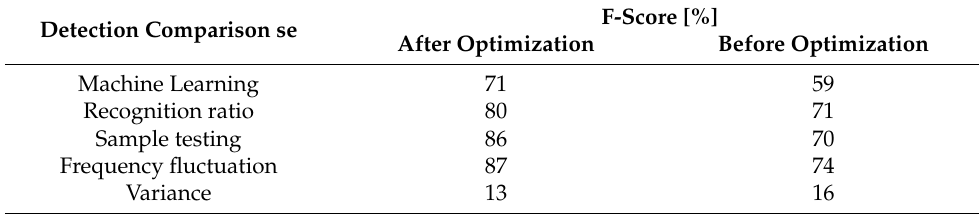
Table 10. Final algorithm output data table. Detection Comparison